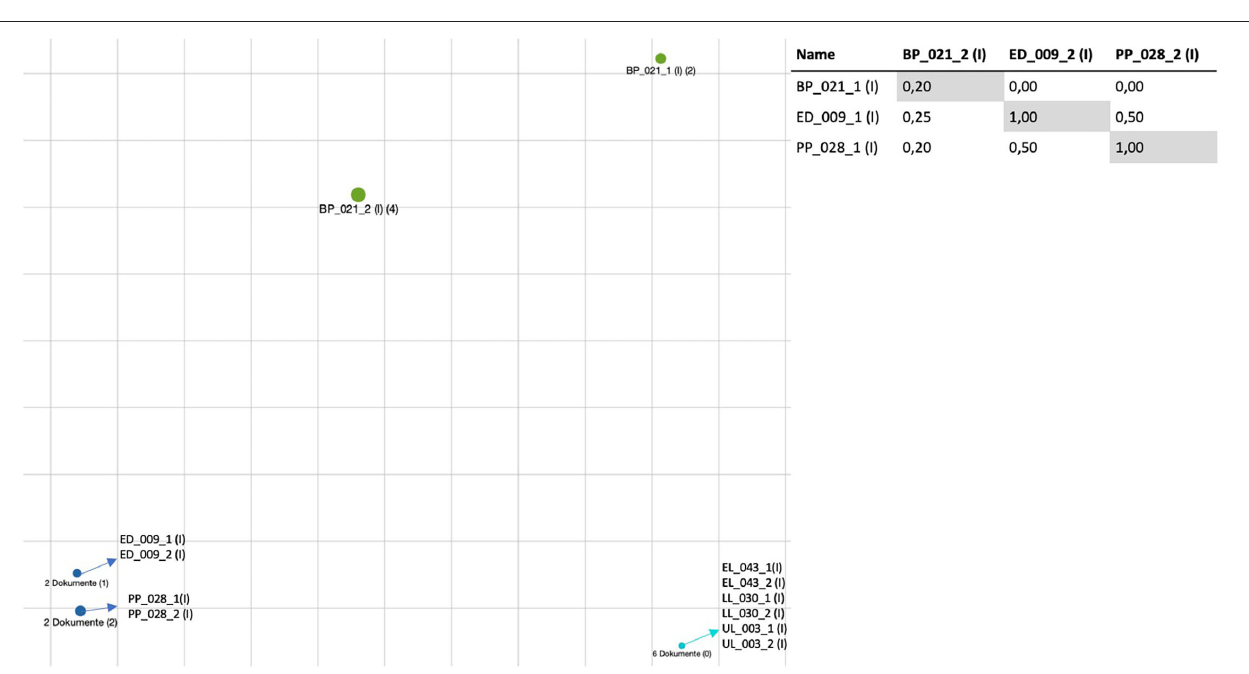
FIGURE 6 | (Left): Similarity map based on Jaccard’s Coefficient for all non-leaders in the emoji condition, based on emoji types. The distance between the individuals’ text excerpts reflects the respective degrees of similarity. (Right): The closer the result is to 1, the more similar the parts of the chats are to each other. Gray indicates “correct” attributions.